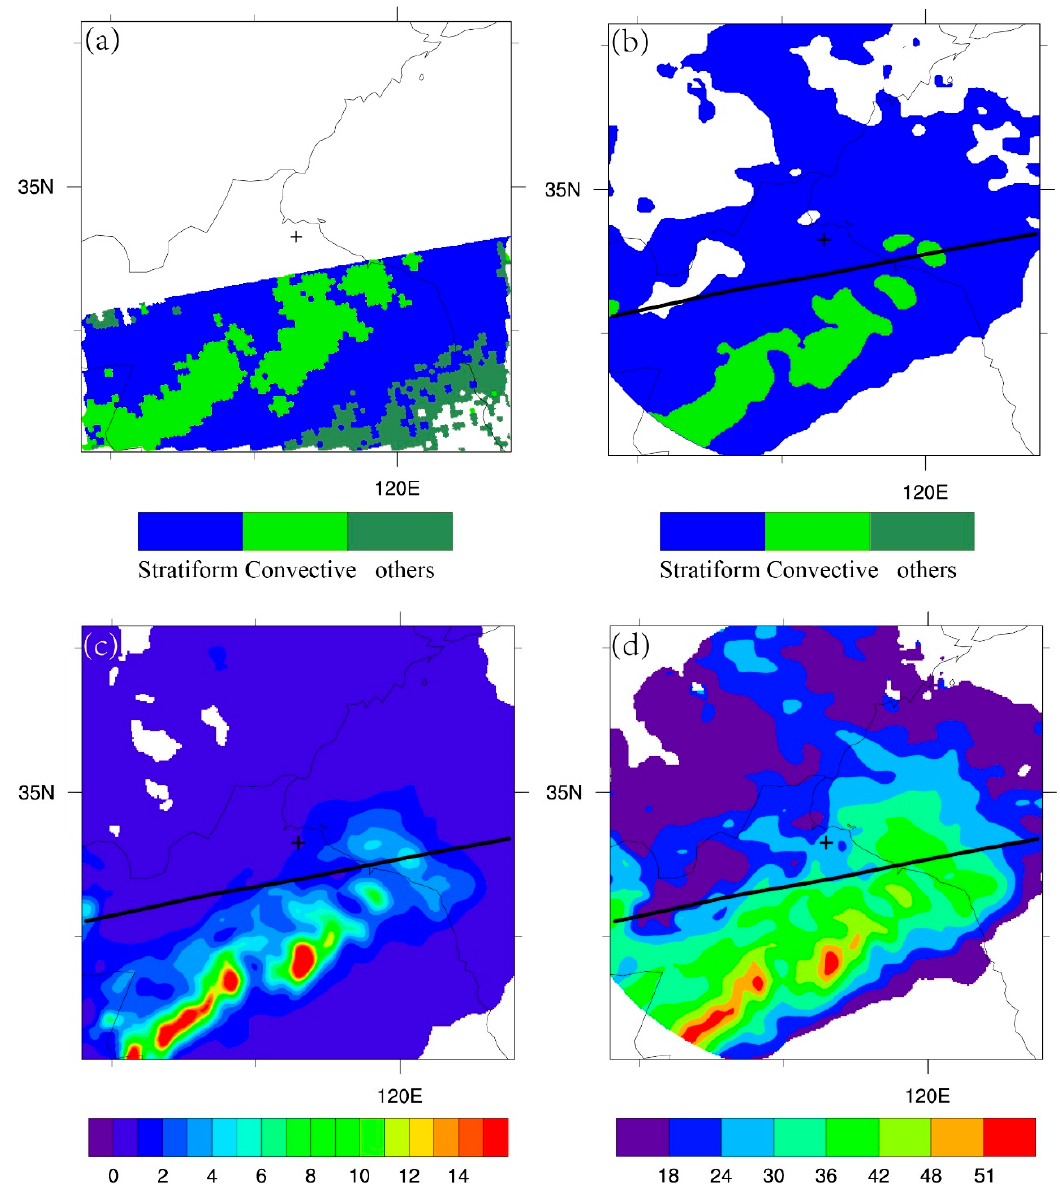
Figure 3. A squall line in Lianyungang at 13:25 (UTC) on July 4, 2012: ( a ) is the classification of the 2A23 product, ( b ) is the KNN classification, ( c ) is VIL, and ( d ) is ref2km. The bold black line represents the boundary of the PR scan range.